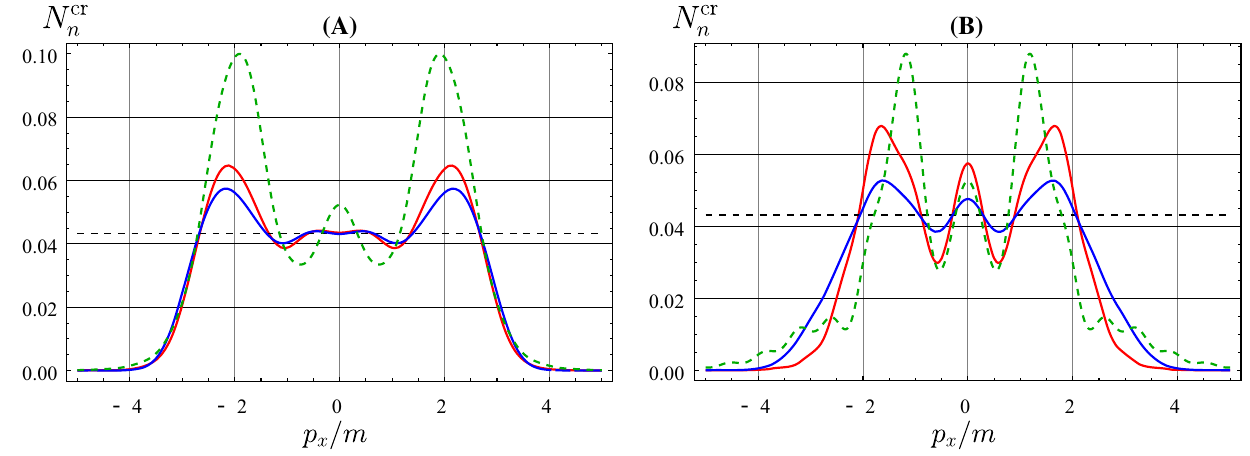
T -constant field while the horizontal ones denotes the uniform distri- bution e − πλ . In both graphs, m τ = 1, mk − 1 = 1, mT = 5 and E = E c